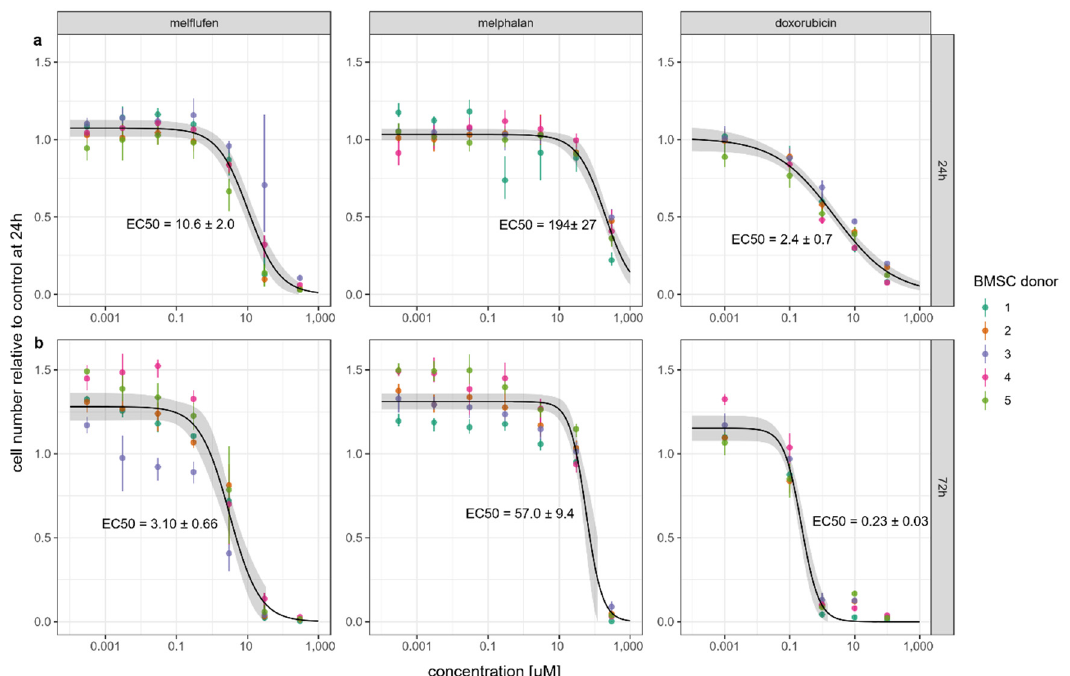
Figure 2. BMSC proliferation in the presence of drugs. Relative number of BMSCs cells at 24 h ( a ) and 72 h ( b ) of culture with drugs at indicated concentrations. Cell number expressed as relative to the control without drugs at 24 h. Dots represent the mean of a color-coded donor cell line cultured in triplicates with crossbars indicating the measured range. Dose–response curve with confidence interval indicated in gray.